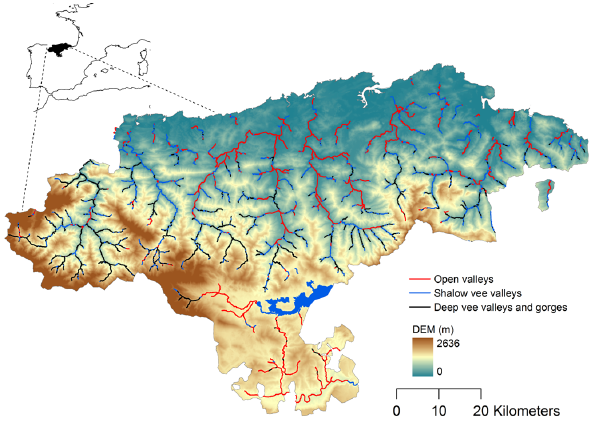
Fig. 1. River network of the Cantabrian region, northern Spain, and spatial distribution of the three considered valley types over the study